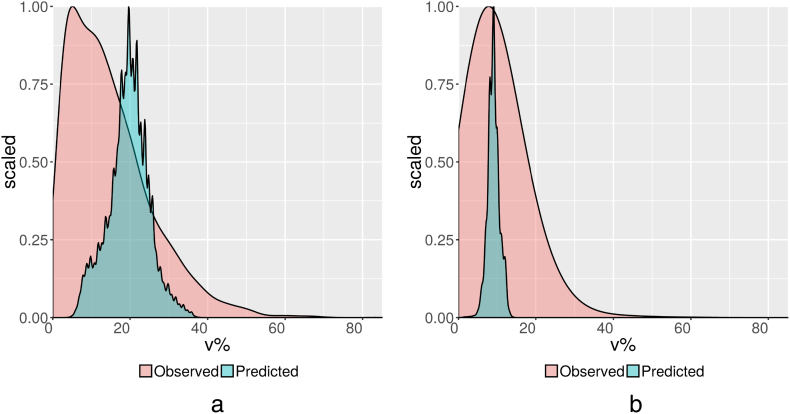
Scaled probability distributions of observed and mapped (predicted) a). VMC at PWP and b). PAWHC.